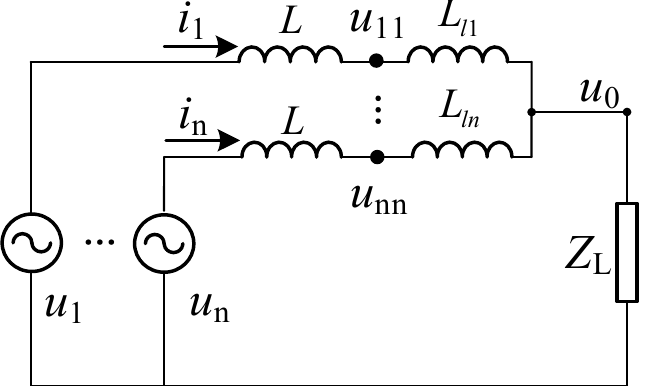
Figure 7. N converters operating in parallel.